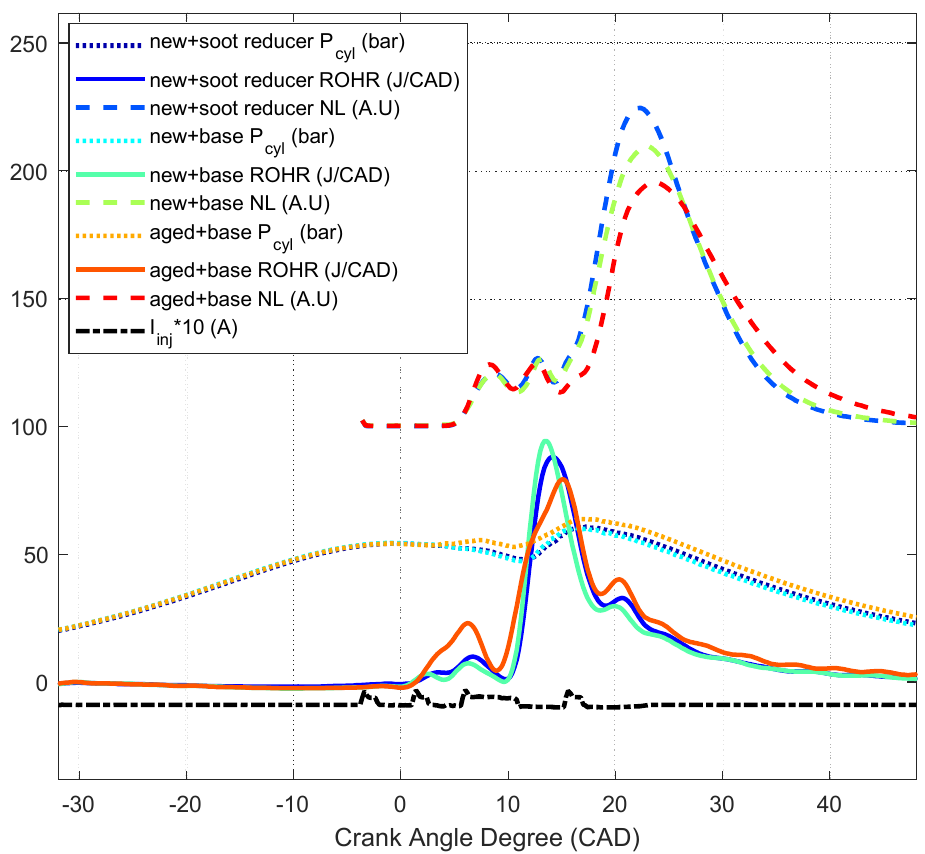
Figure 20. Pressure, heat release rate and spatial integration of natural luminosity signal during combustion at medium load.